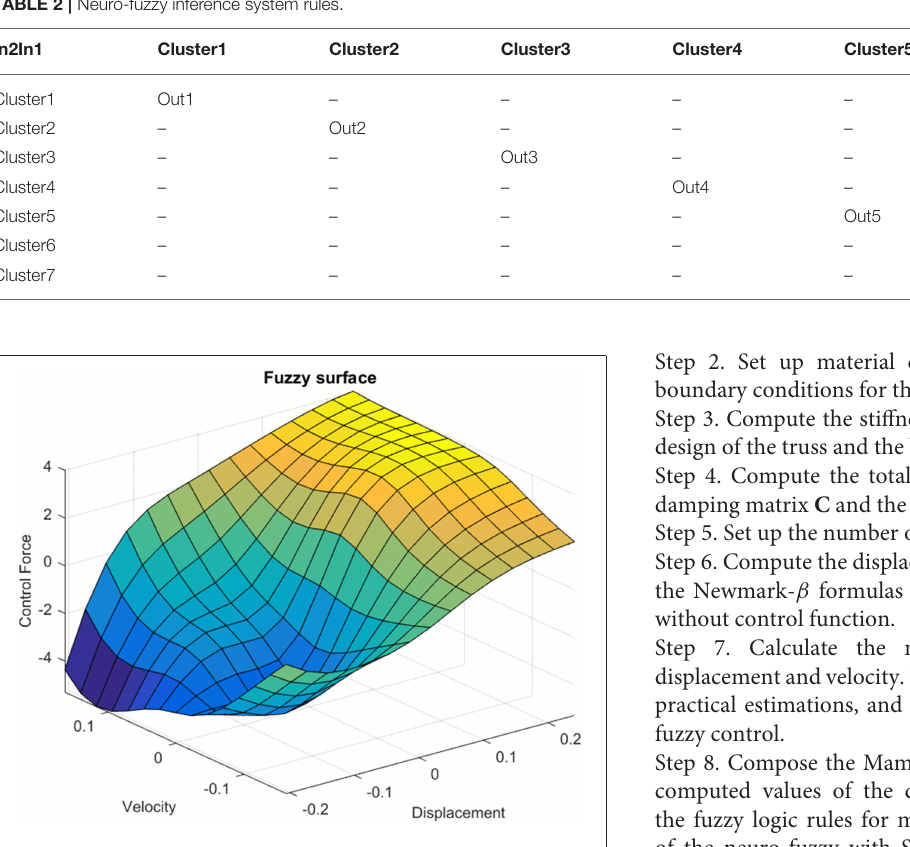
FIGURE 7 | Fuzzy surface of the Sugeno-type neuro-fuzzy controller.